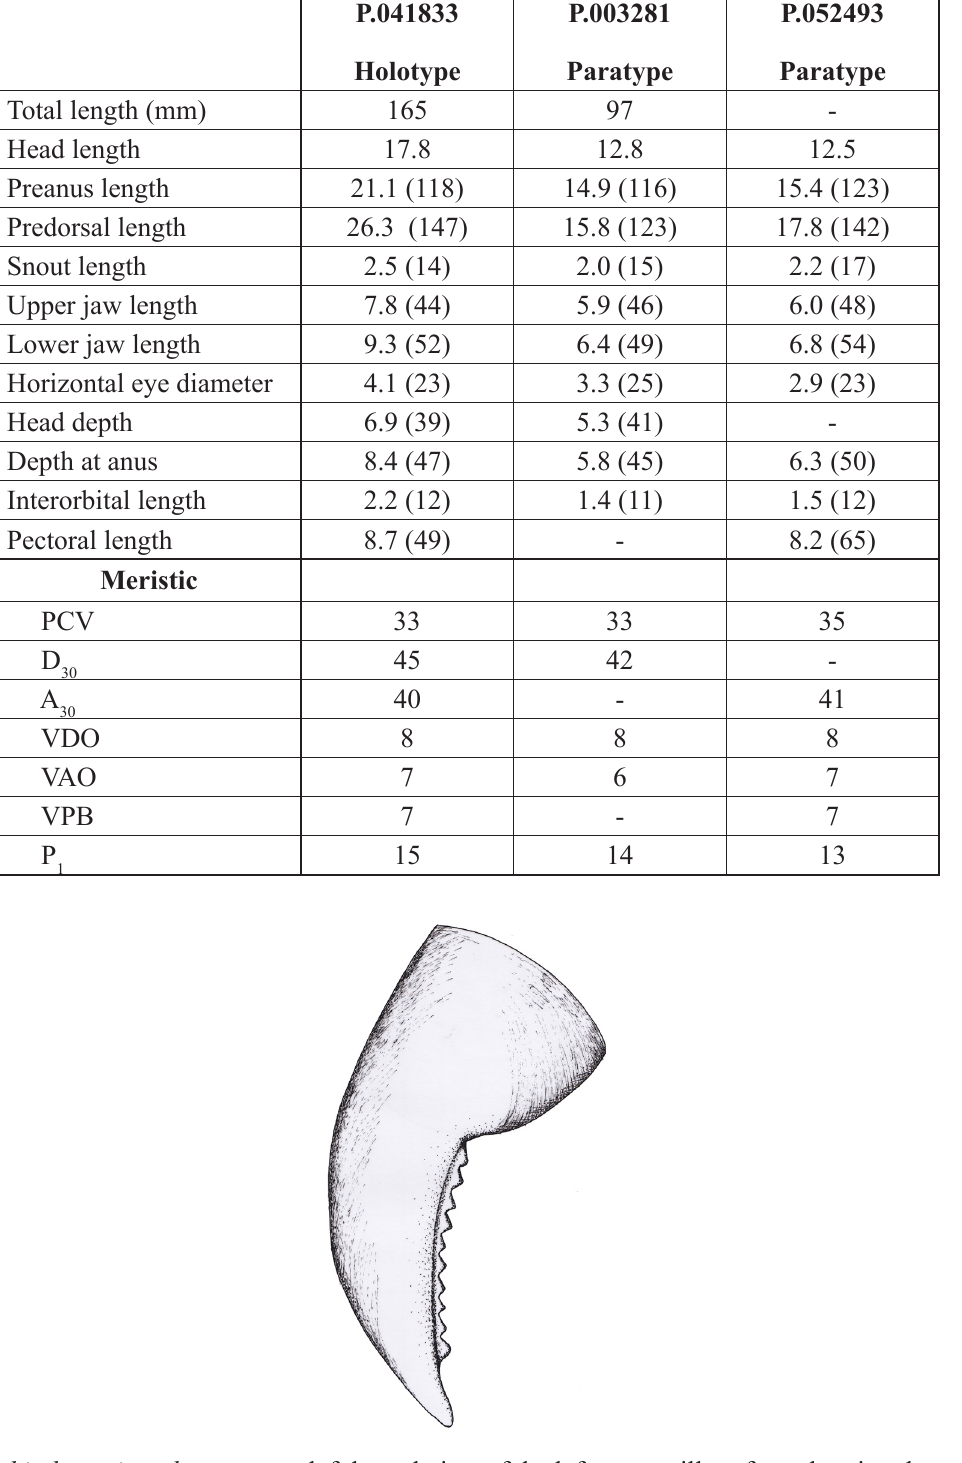
Fig. 2. Echiodon prionodon sp. nov., left lateral view of the left premaxillary fang showing the posterior serrated margin.